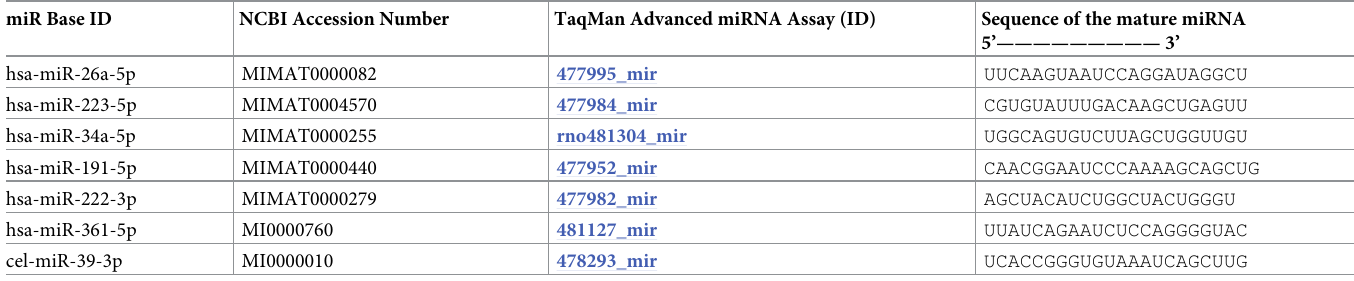
Table 2. Identification of the candidate microRNAs, of the three endogenous normalizer microRNA used and of the spike quality control of the